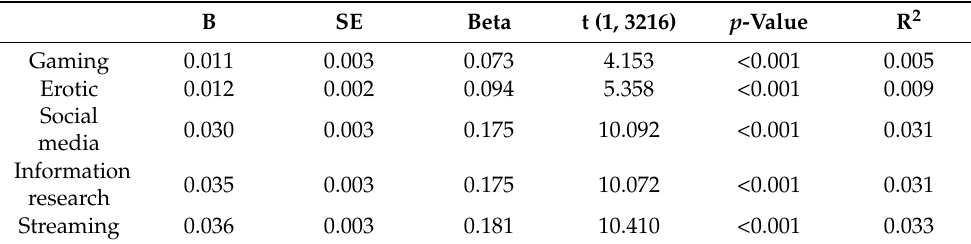
Table 5. Regression coefficients regarding pandemic related stress levels and changes in online media